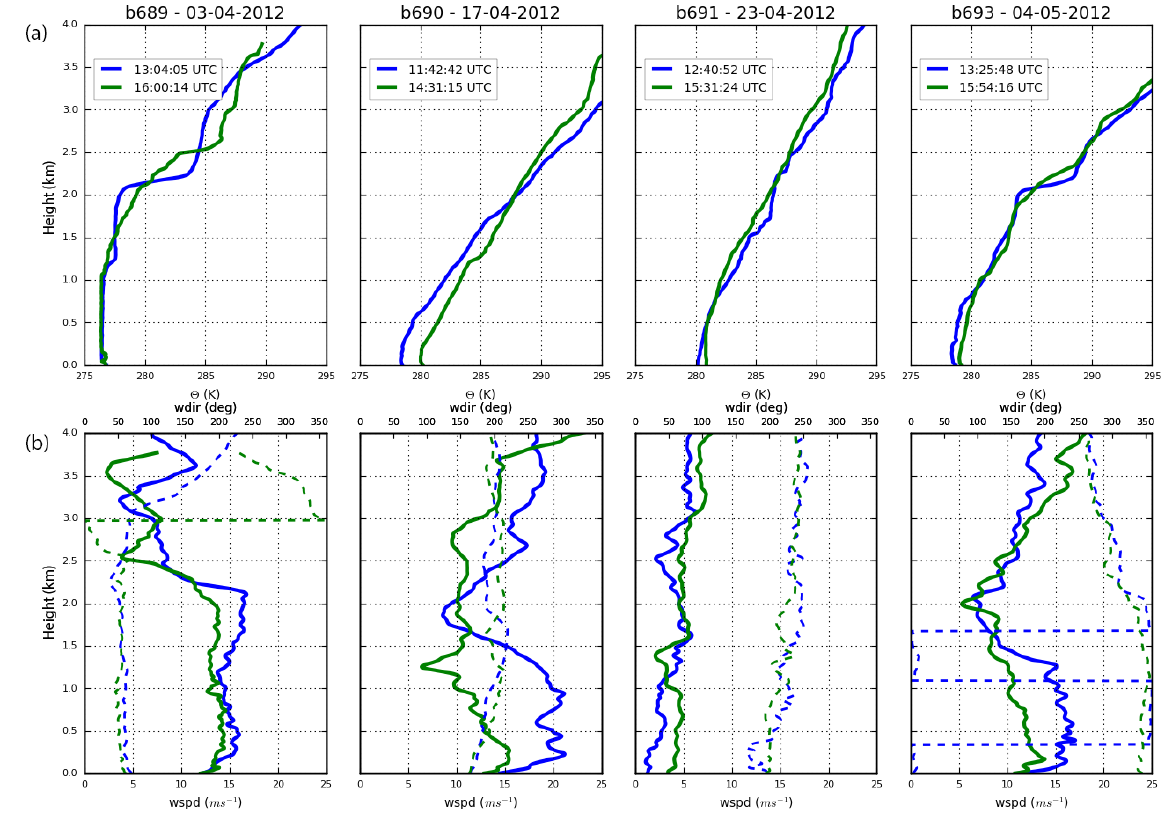
Figure 5. Profiles of potential temperature (a) and wind speed (solid lines) and direction (dashed lines; b ) from dropsonde data early (blue) and late (green) in the flight for B689, B690, B691, and